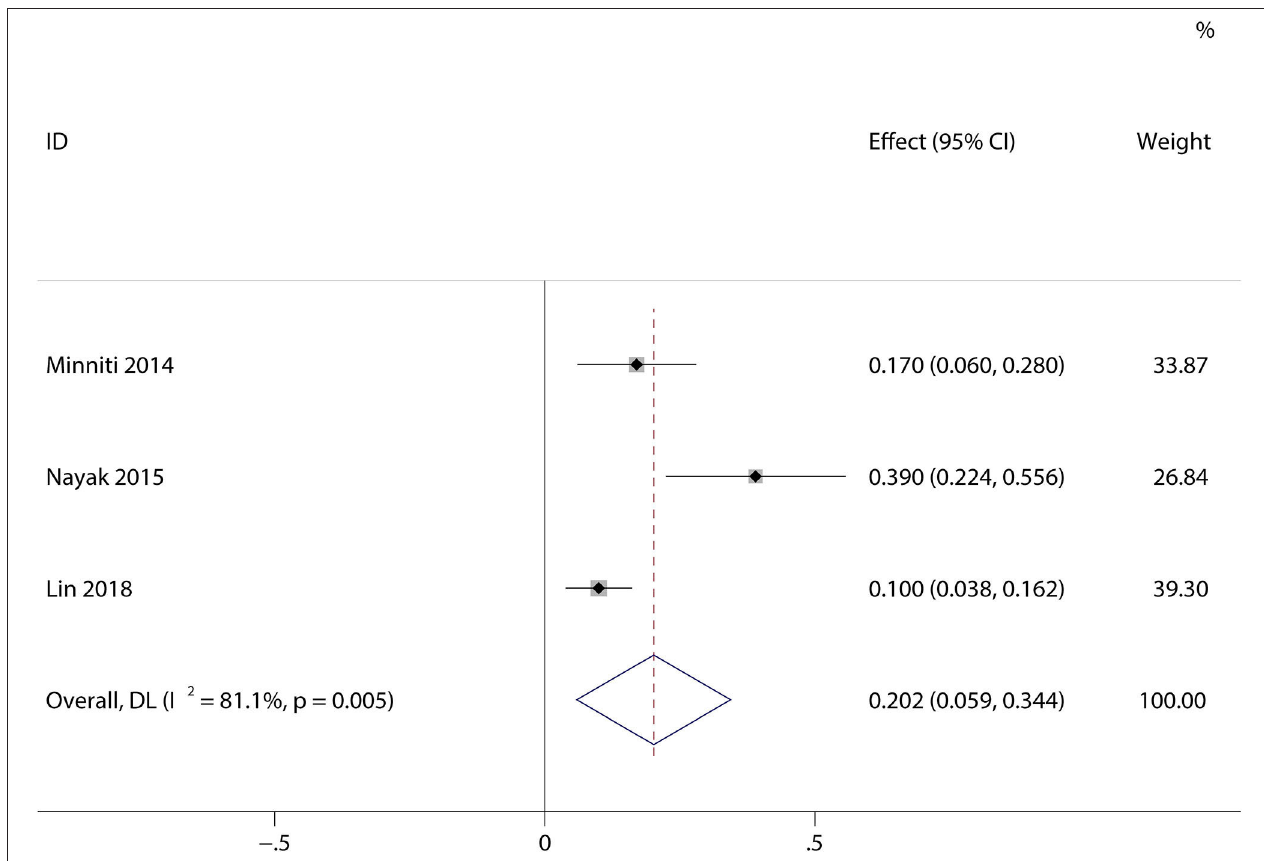
FIGURE 3 | Forest plots of the incidence rate of severe lymphopenia and 95% CIs in astrocytoma and astrocytoma oligodendroglioma patients. Weights are from random-effects